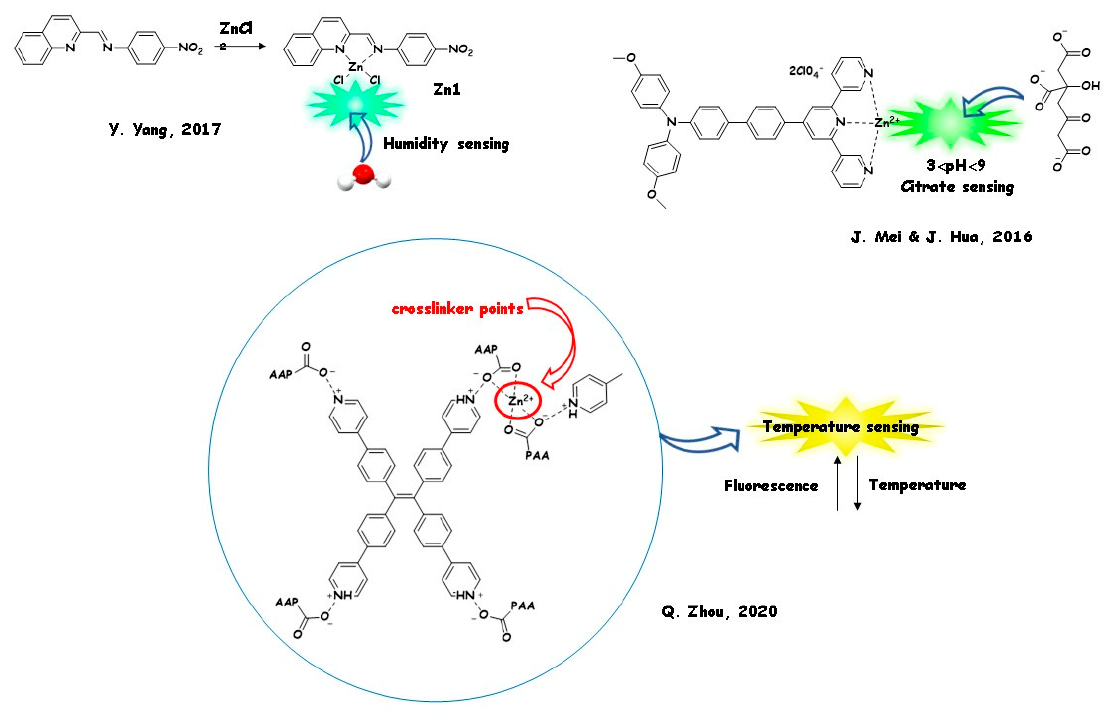
Figure 7. Relevant examples of zinc (II)-based AIE active sensors.